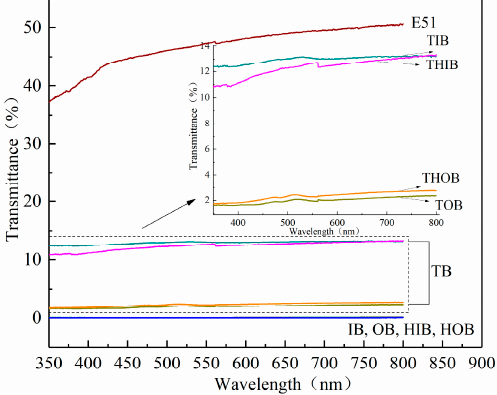
Figure 7. Comparison of the transmittance of different types of bamboo material and TB.